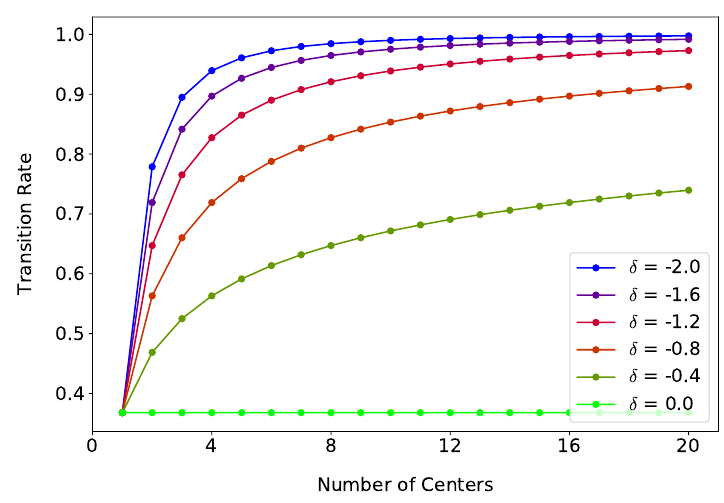
Figure 9: The transition rate Γ ( N → N + 1 ) versus N for a range of values of δ , with γ =